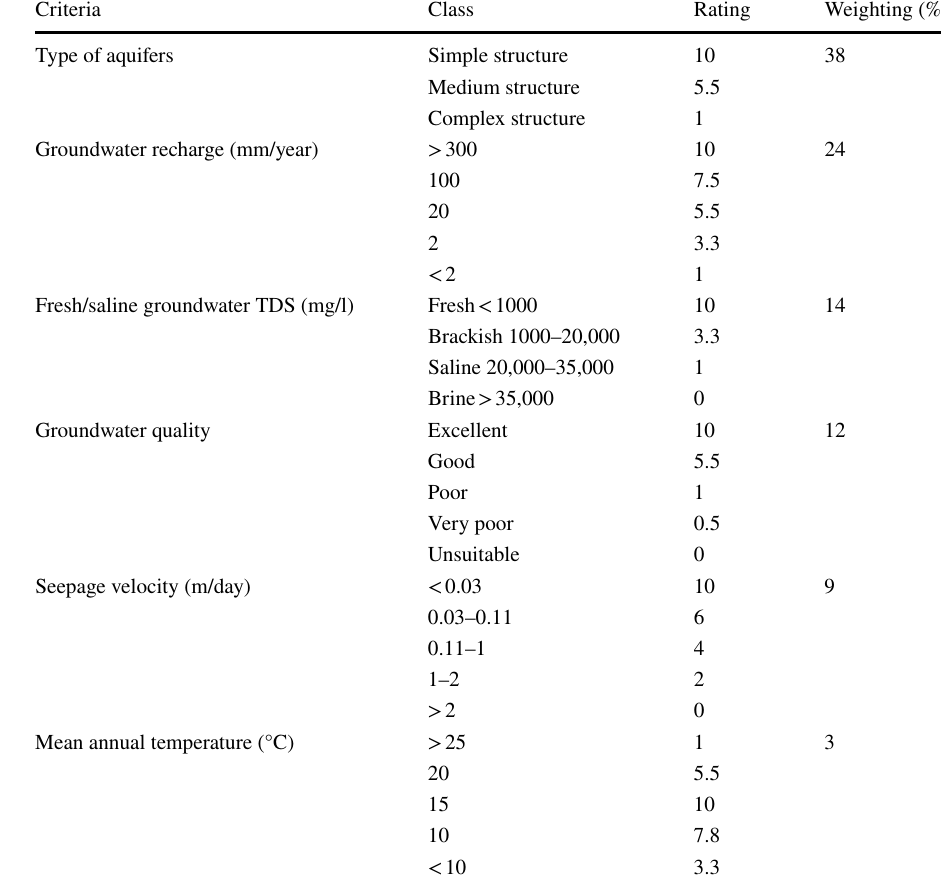
Table 2 Criteria class, rating, and weighting used in the ATES suitability map